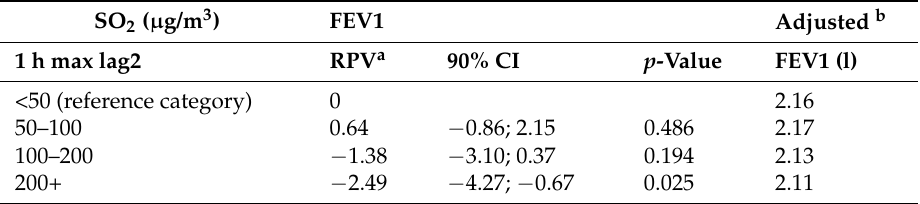
Table 6. Dose-response relation between SO 2 (1 h max lag2) and FEV1 in the Panel 20 study: relative percent variation (RPV) and adjusted FEV1. Sarroch (Sardinia), Italy (January–June 2007). SO 2 ( µ g/m 3 ) FEV1